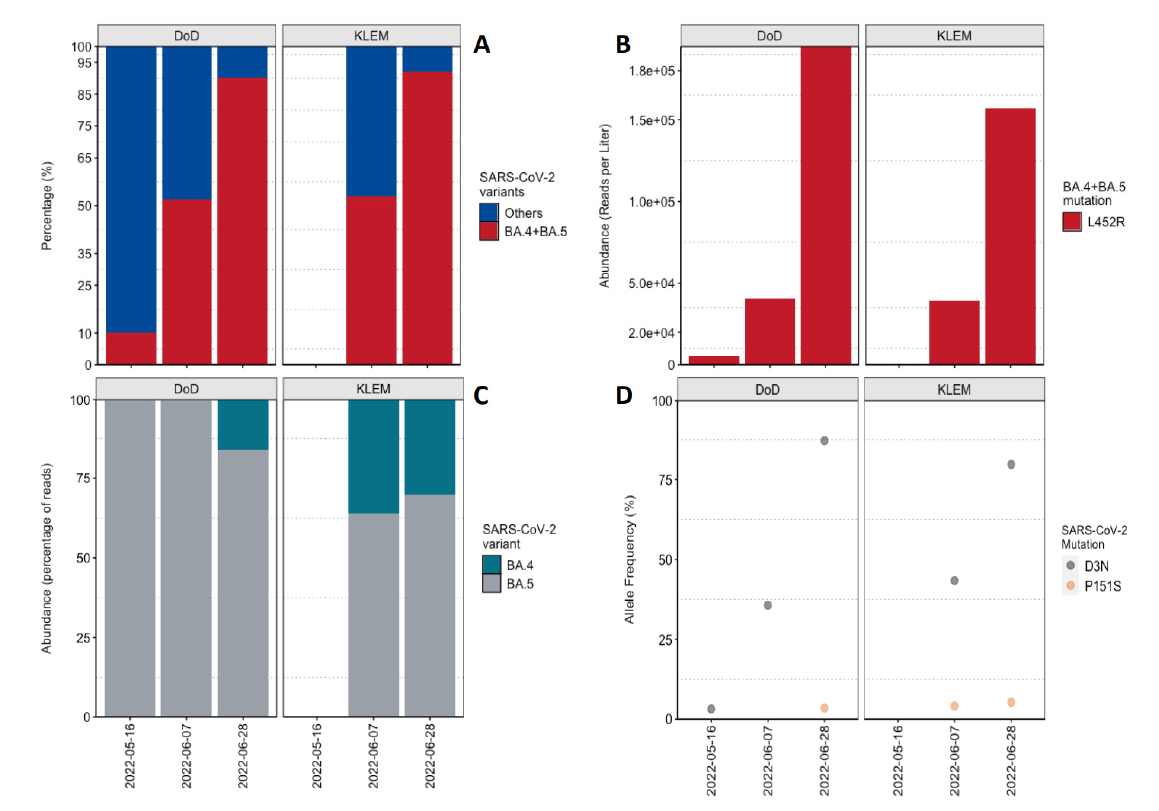
Figure 5. Sequencing of wastewater samples for confirmation of SARS-CoV-2 BA.4 and BA.5 subvariants. ( A ) Percentage abundance of BA.4 and BA.5 together in comparison to the other SARS-CoV-2 variants based on the read abundance of the L452R spike protein mutation. ( B ) Plot showing the increase in the read abundance of the L452R mutation, which is associated with BA.4 and BA.5 during the sampling period. ( C ) Percentage abundance of BA.4 and BA.5 based on their unique mutations, i.e., D3N for BA.5 and P151S for BA.4. ( D ) Allele frequency of the D3N and P151S mutations detected in the samples.